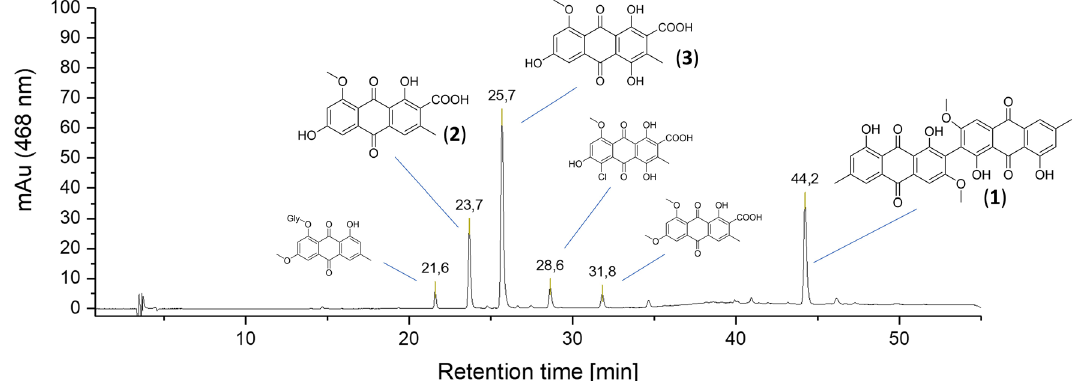
Figure 2. HPLC chromatogram (λ det = 468 nm) of the EtOAc fraction of C. uliginosus obtained by a liquid– liquid fractionation from the methanol extract. The detection wavelength was fitted to the excitation wavelength of the accompanied assays (i.e., (photo)cytotoxicity and DMA assay). Peaks of interest are indicated by their retention time and by the identified structure. The small structures indicate solely annotated structures, while the normal-sized ones are such which were isolated and are thus structurally verified. Stationary phase: Max RP, Mobile Phase (H 2 O/ACN + 0.1%FA), gradient (for details refer SI, Chapter